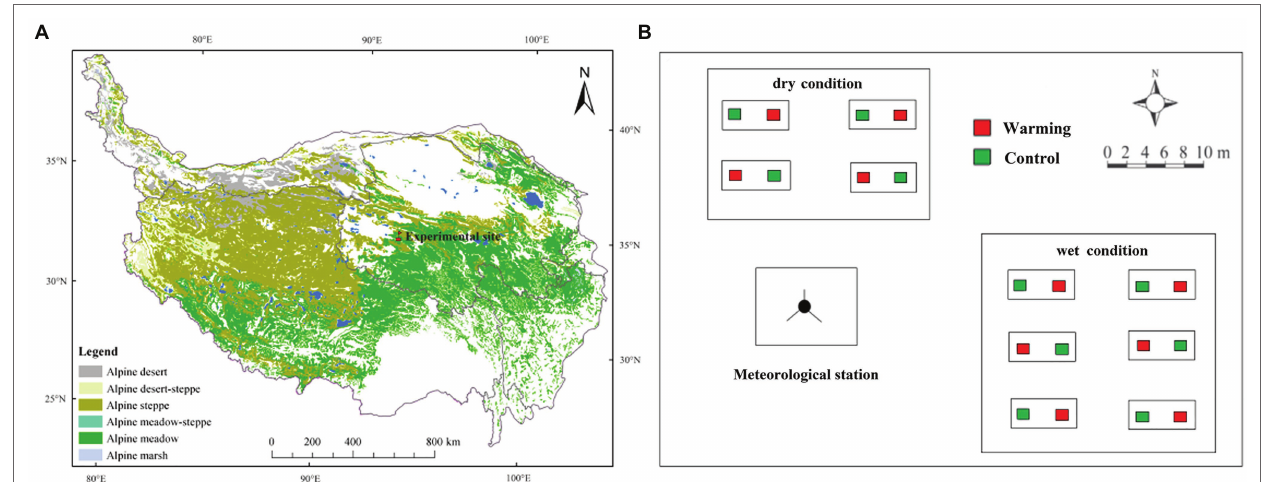
FIGURE 1 | The location of the experimental site (A) , and layout of experimental design (B)